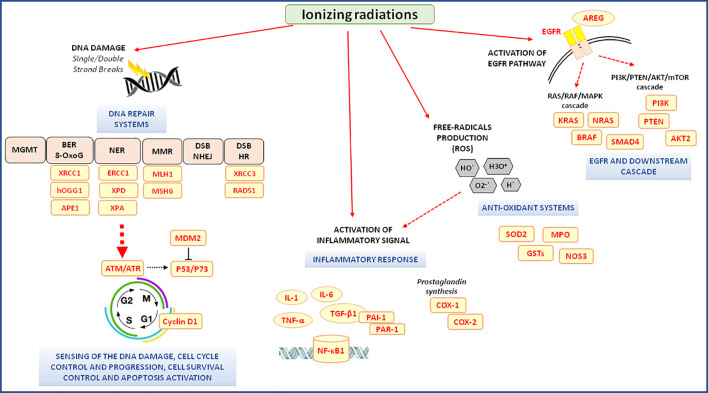
Radiotherapy-related molecular pathways associated with the clinical outcome of neo-adjuvant chemoradiotherapy in locally advanced rectal cancer patients. 8-oxoG, 8-oxoguanine; AKT, v-akt murine thymoma viral oncogene homolog; APE1, apurinic/apyrimidinic endodeoxyribonuclease 1; AREG, amphiregulin; ATM, ATM serine/threonine kinases; ATR, ATR serine/threonine kinases; BER, base excision repair; COX-1, -2; cyclooxygenase 1, -2; DSB, double-strand breaks; EGFR, epidermal growth factor receptor; ERCC1, ERCC excision repair 1; GSTs, glutathione S-transferases; hOGG1, 8-oxoguanine DNA glycosylase; HR, homologous recombination; MDM2, MDM2 proto-oncogene; MGMT, O6-methylguanine DNA methyltransferase; MLH1, mutL homolog 1; MMR, DNA mismatch repair; MPO, myeloperoxidase; MSH6, mutS homolog 6; mTOR, mammalian target of rapamycin; NER, nucleotide excision repair; NF-κB1, nuclear Factor Kappa B Subunit 1; NHEJ, non-homologous end joining; NOS3, nitric oxide synthase 3; P53, tumor protein p53; P73, tumor protein p73; PAI-1, plasminogen activator inhibitor type 1; PAR-1, protease-activated receptor-1; PI3K, phosphoinositide-3-kinase; PTEN, phosphatase and tensin homolog; RAD51, RAD51 recombinase; ROS, reactive oxygen species; SMAD-4, SMAD family member 4; SOD2, superoxide dismutase 2; TGF-β1, transforming growth factor beta 1; TNF-α, tumor necrosis factor-alpha; TRBP, trans-activation-responsive RNA-binding protein; XPA, xeroderma pigmentoso complementation group A; XPD, xeroderma pigmentoso complementation group D; XRCC1, -3, x-ray repair cross-complementing 1, -3.